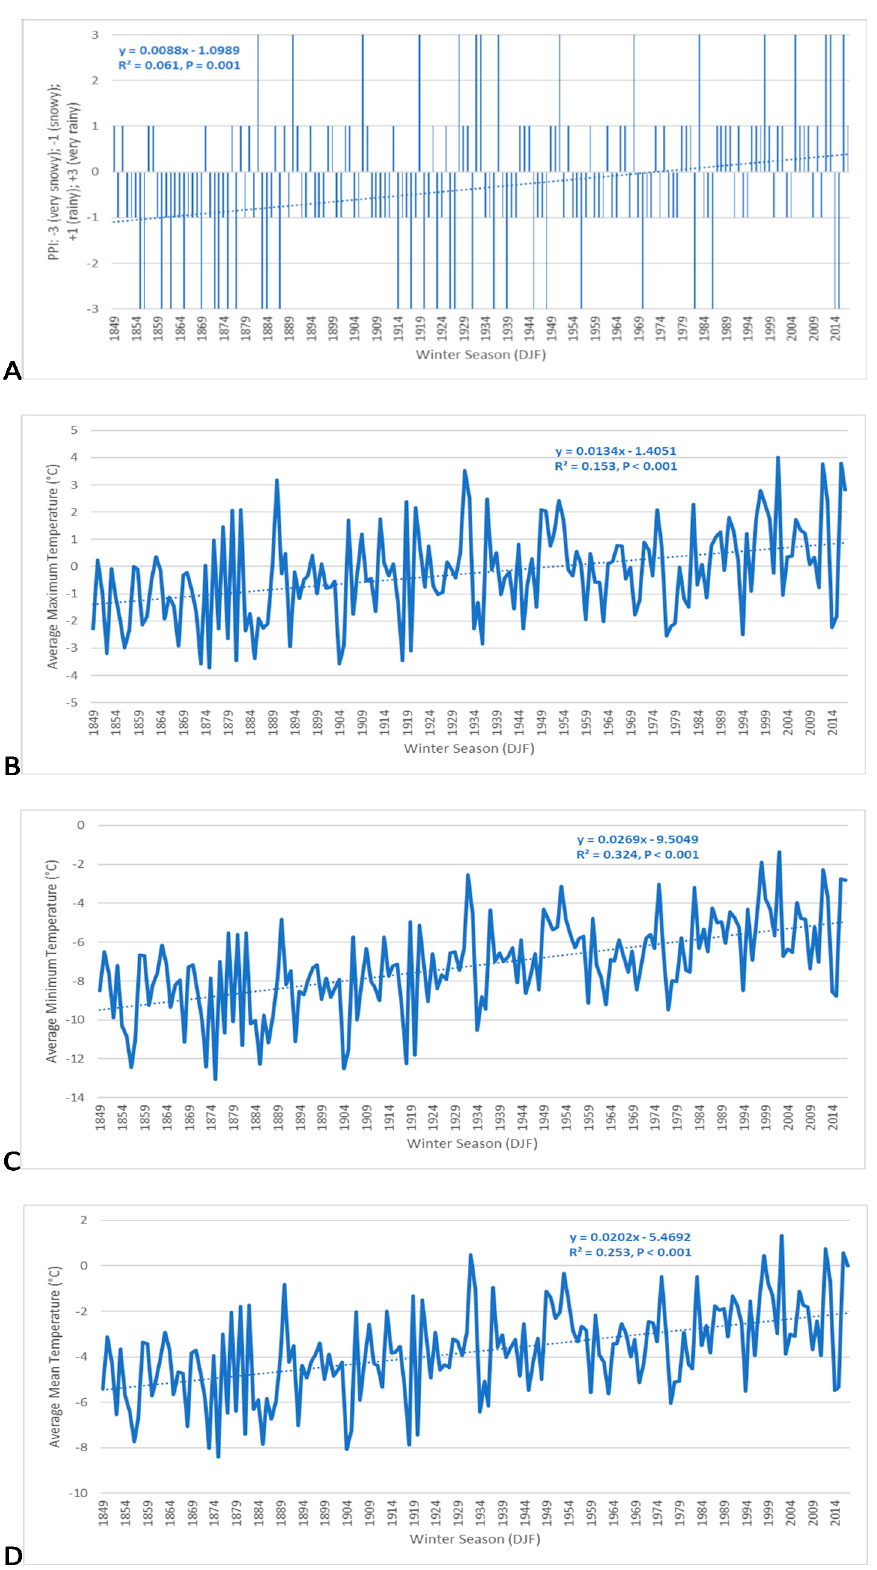
Figure 3. Trends in a ) precipitation phase index (PPI), b ) maximum temperatures, c ) minimum temperatures, and d ) mean temperatures for winters in Toronto (1849–2017).